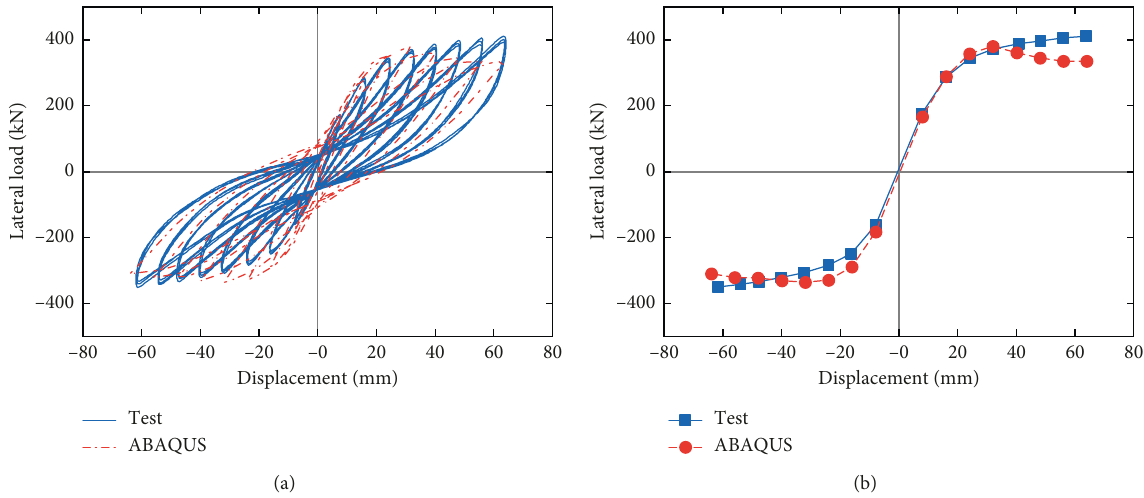
Figure 20: Comparison between the computed curves and experimental ones. (a) Hysteresis curve. (b) Skeleton